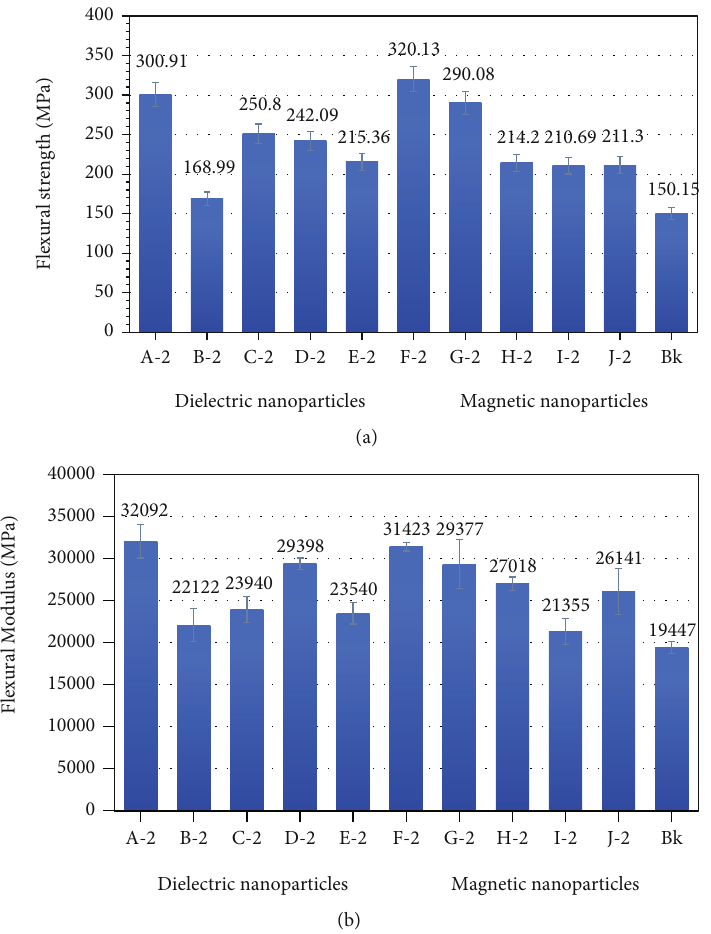
Figure 12: E ff ect of magnetic and dielectric nano fi llers on (a) fl exural strength and (b) fl exural modulus (A: MWCNTs, B: SiC, C: Gp, D: CB, E: MnO , F: TiO , G: CoO, H: NiO, I: ZiO, J: Fe 2 2